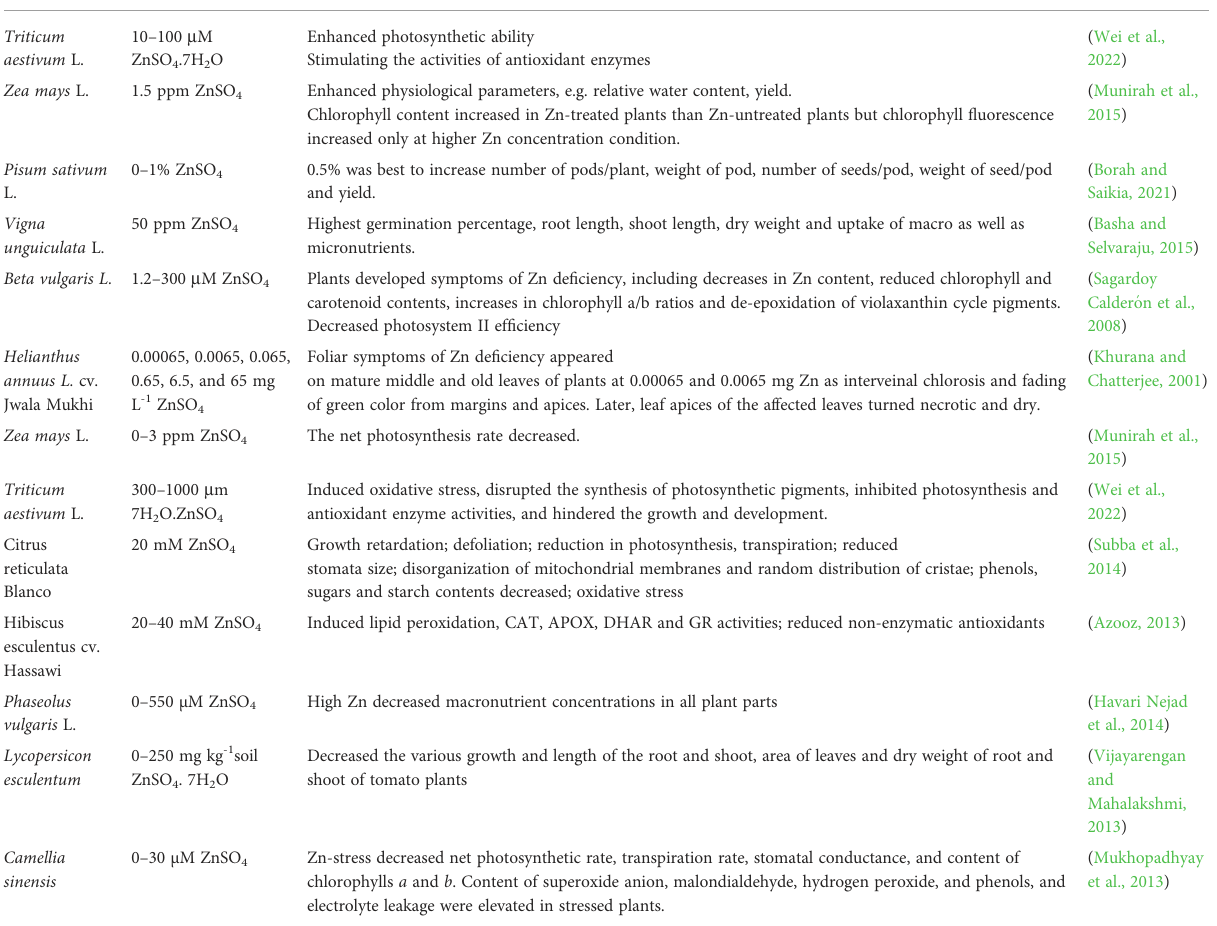
TABLE 1 Bene fi cial, de fi ciency symptoms, and toxic effects of zinc on plants.